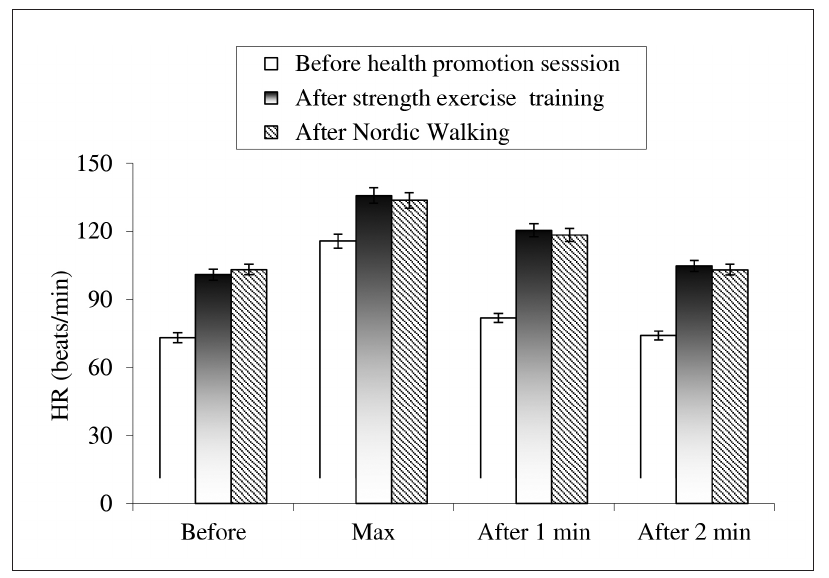
Figure 1. HR changes while performing Roufier Exercise